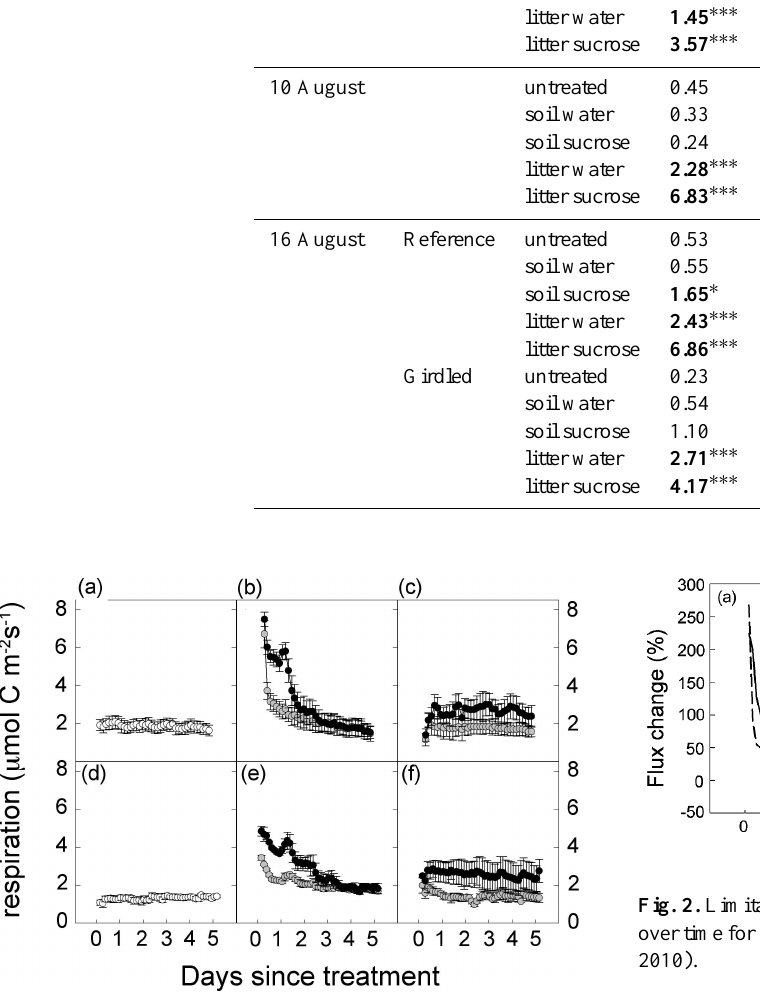
Fig. 1. Reference site experiment 1 (top row) and experiment 2 (bot- tom row) mean respiration ( ± 1SE) in (a, d) control, (b, e) litter surface, and (c, f) mineral soil applications. Light grey symbols in- dicate water-only, and black symbols indicate sucrose+water treat- ments.